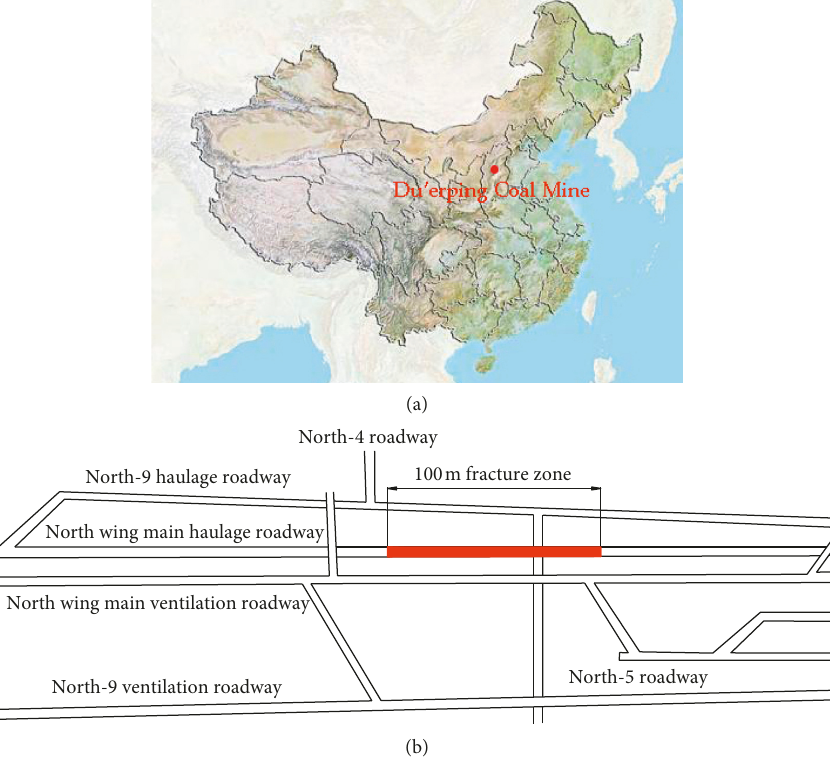
Figure 1: (a) Location of the Du’erping coal mine. Shanxi, China. (b) Location of the fracture zone in the north wing of the main haulage roadway.